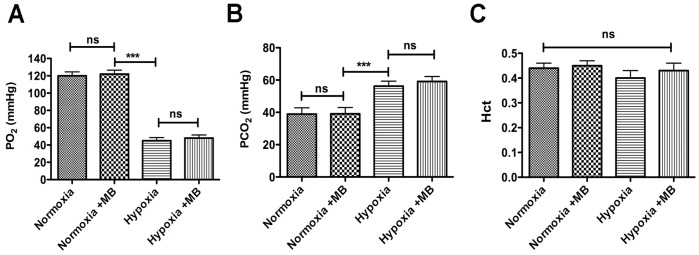
MB did not affect PO2, PCO2, and hematocrit (Hct).(A) PO2 decreased under hypoxia but did not change with MB treatment (under either condition). (B) PCO2 increased under hypoxia but did not change with MB treatment (under either condition). (C) Hematocrit was not affected by gas type or MB treatment. Data are mean ± SD; ***, p<0.001; ns, not significant.